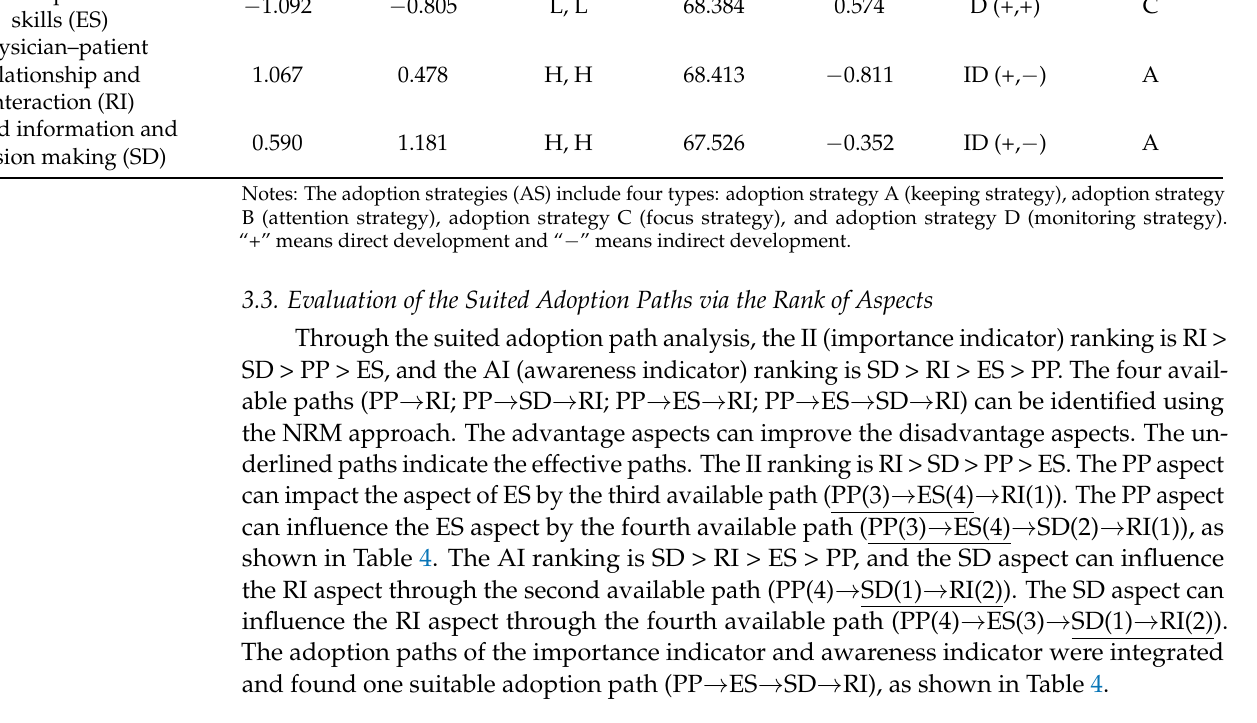
Table 4. The suited adoption paths of SDM competency